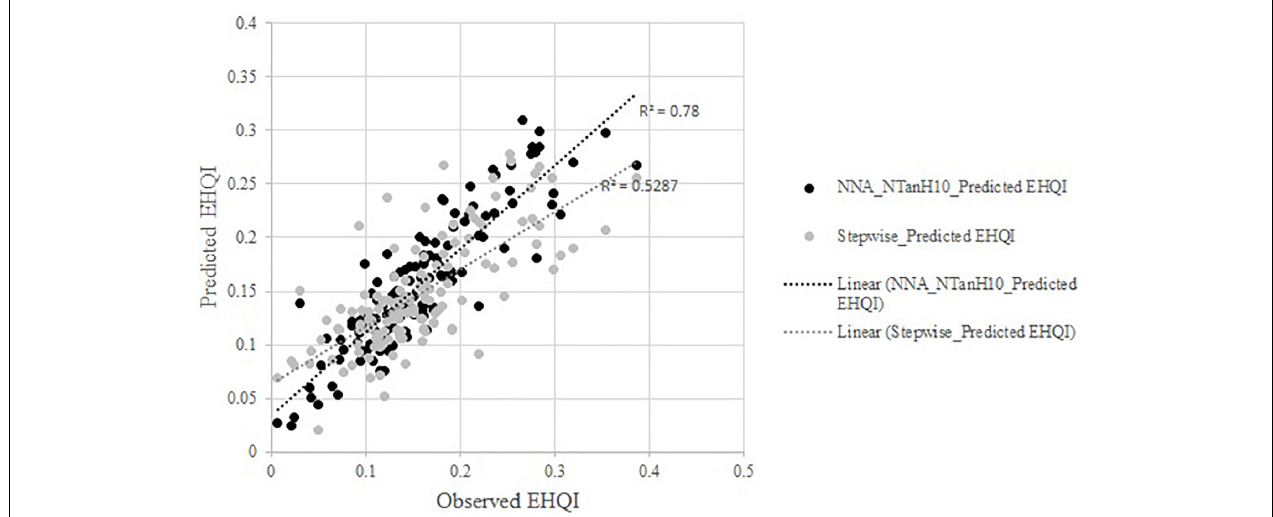
FIGURE 5 | Plot of predicted Edamame Harvest Quality Index ( EHQI ) by Neural Network Analysis and stepwise analysis as a function of the observed EHQI . Neural network model with NTanH(10) assuming dependent resampled inputs. Both models utilized phenological and thermal functions for the prediction of EHQI